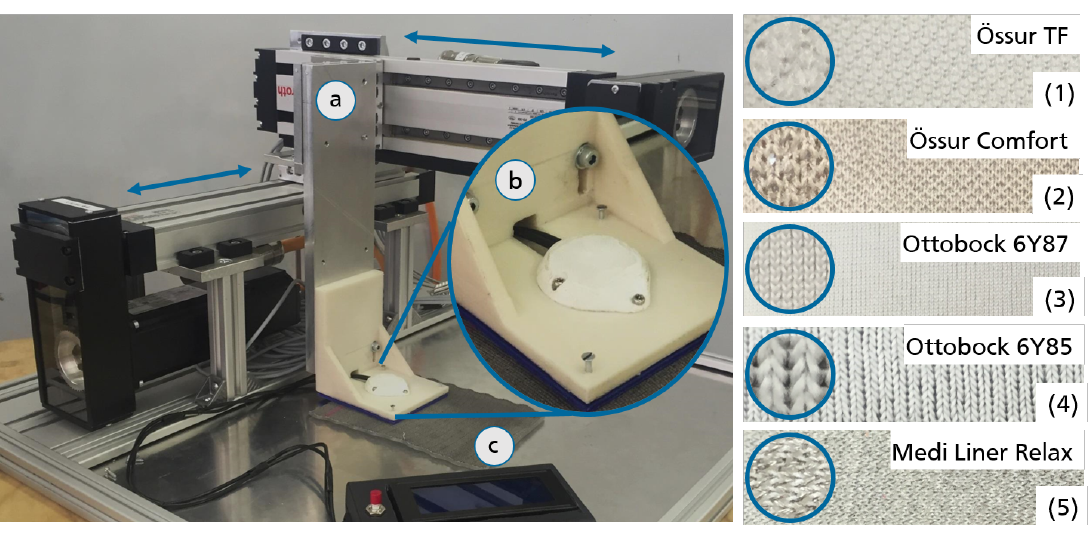
Figure 2. Test rig setup with indicated movement possibilities: a movable cantilever, b affixed sensor unit, and c stationary reference surface textures ( left ) and tested liner materials ( right ).